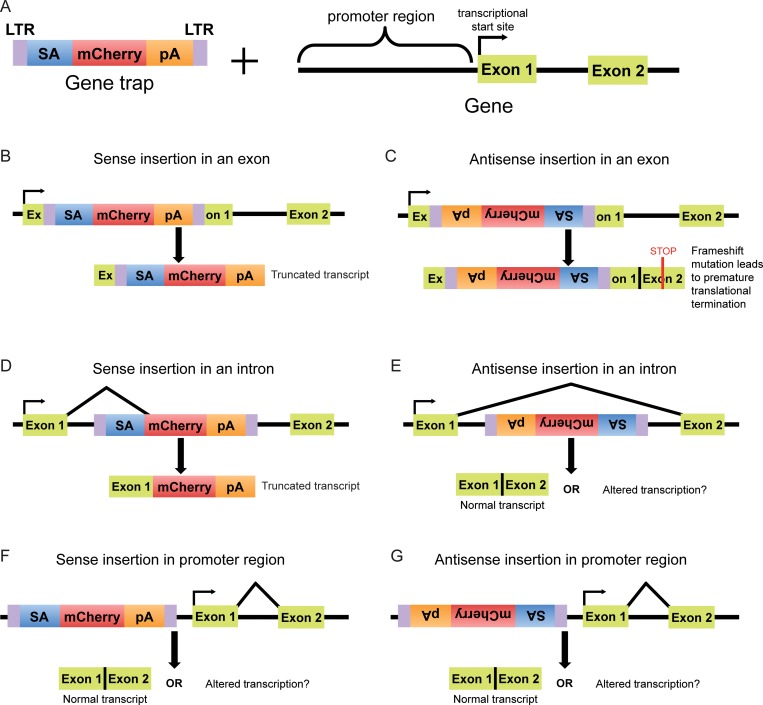
Possible outcomes of GT insertions in different genetic features.(A) A GT consists of direct long terminal repeats (LTRs), a strong splice acceptor (SA), a reporter gene (mCherry) and a poly-adenylation (pA) sequence. A schematic of the 5’ end of a gene, including the promoter region, is also shown. (B) A GT can disrupt a gene by inserting into an exon in the sense orientation (with respect to the coding sequence of the gene), interrupting the coding sequence and causing premature transcriptional termination due to the pA sequence. (C) An antisense GT insertion into an exon interrupts the coding sequence of the gene and typically causes a frameshift mutation that leads to premature translational termination, producing a truncated protein. (D) When a GT integrates into an intron in the sense orientation, the SA causes the reporter gene and pA sequence to be spliced to the preceding exon, inevitably leading to premature transcriptional termination due to the pA sequence. (E) An antisense GT insertion in an intron will typically not disrupt a gene due to the directionality of the SA; however, it could interfere with regulatory elements or with transcripts present on the antisense strand. (F, G) GT insertions in the promoter region of a gene in either the sense or antisense orientation generally do not affect the downstream transcript; however, they could potentially disrupt regulatory elements and alter transcription.